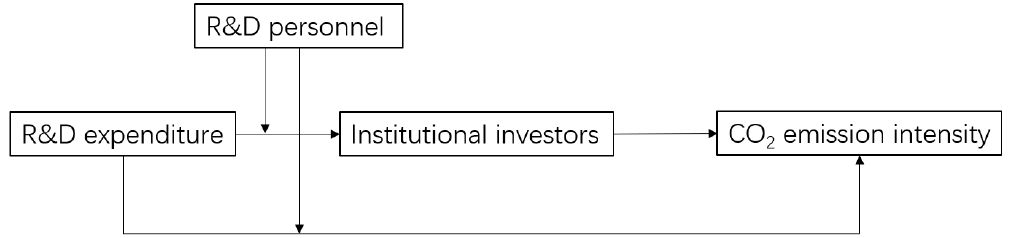
Figure 2. Logic diagram about the first half path of mediated moderating effect. As shown in column (1) of Table 10, which shows the results of model (4), the regression coefficient of the intersection term, RD ∗ RP , is significantly positive at the 1% level, indicating that R&D personnel plays a moderating role on R&D expenditure and CO 2 emission intensity, and